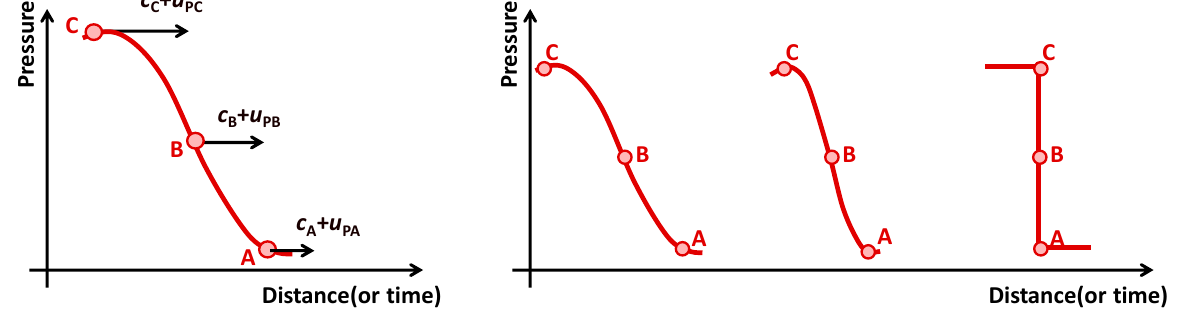
Figure 4. Explanation of the formation of a shock front starting from a smooth wave beyond the elastic limit; at each point, the velocity of the pressure wave is the sum of the speed of sound and the particle velocity proper of the conditions in which the point is ( C C + U p C > C B + U p B > C A + U p A ).